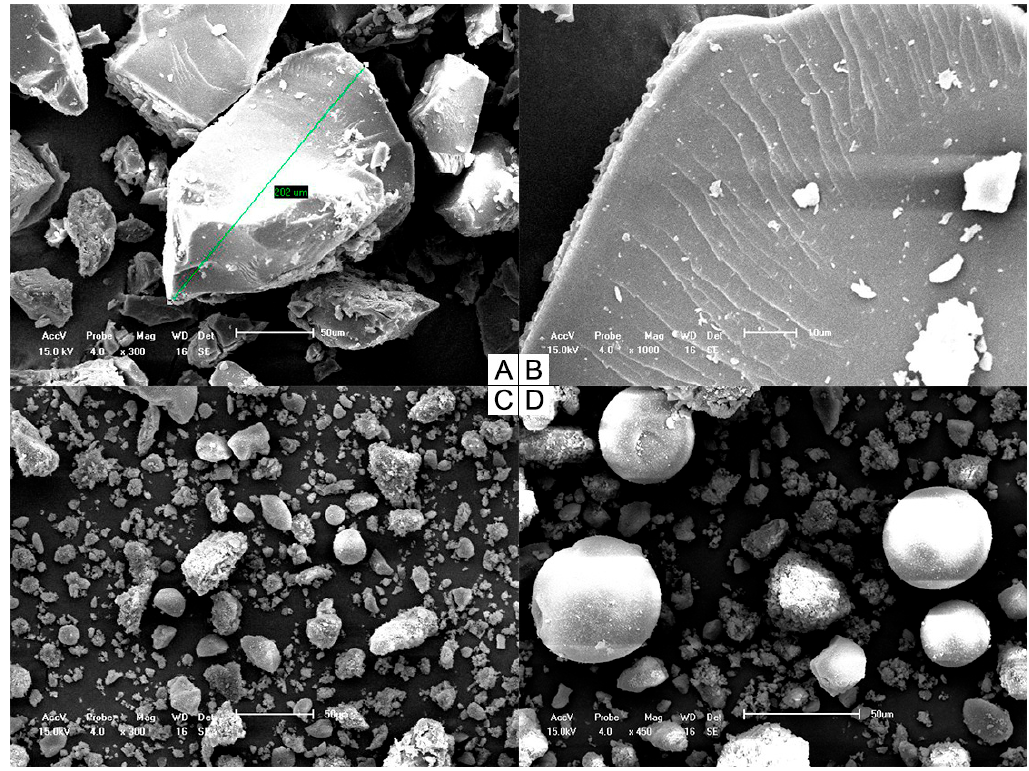
Figure 2. Scanning electron micrographs of both SD 30% ( A ) 300× and ( B ) 1000× and PM 30% ( C ) 300× and ( D ) 450×.